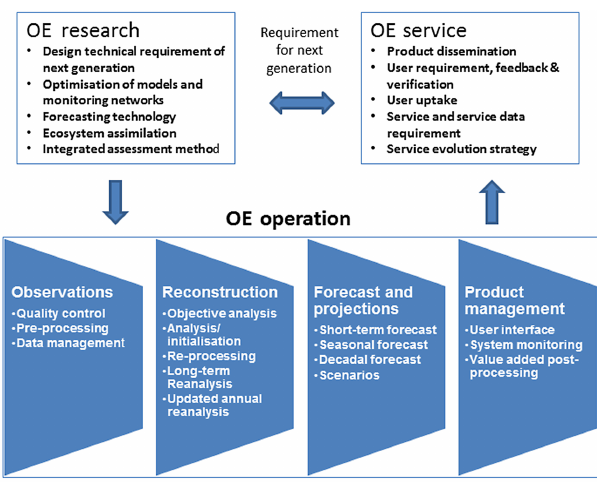
Figure 2. Flowchart of the operational